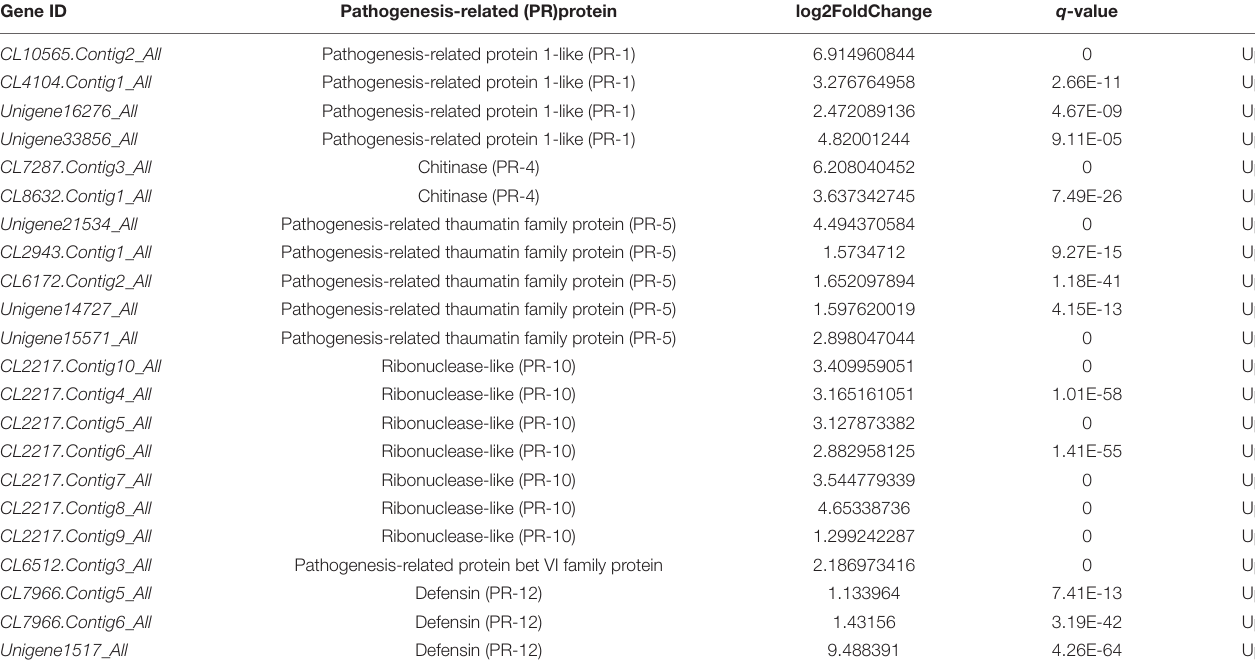
TABLE 2 | Genes regulating PR proteins in the NM vs NMP.